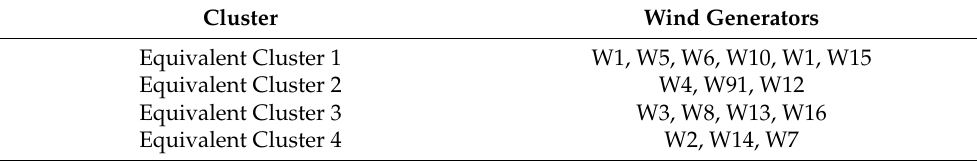
Figure 8. ( a ) Multi-scale entropy of active power in W1–W16. ( b ) Multi-scale entropy of reactive power in W1–W16. Table 3. Cluster of wind generators.